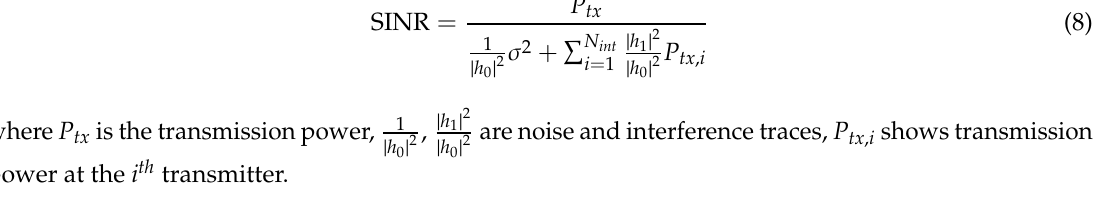
Figure 7. Non-Linear Auto Regressive External/Exogenous (NARX) [42].